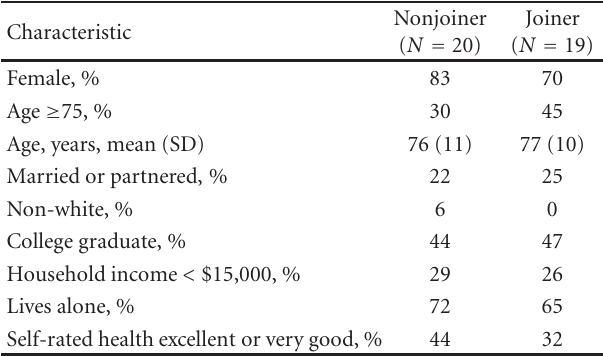
Table 1: Participant demographics and self-perceived health, by joiner